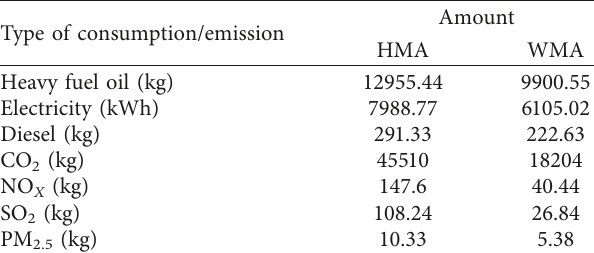
Table 3: The LCIs of mixing every 1000m 3 HMA and WMA